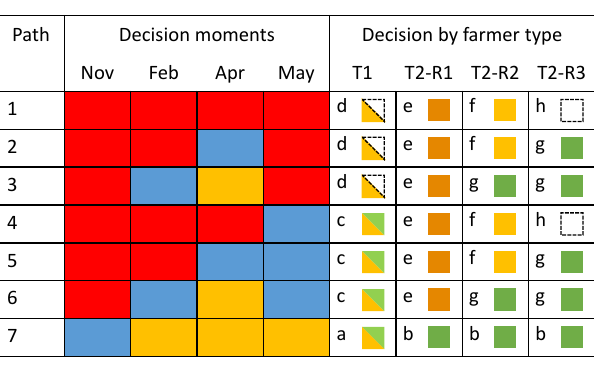
Table 1. Possible paths for farmers. The paths are the result of the water availability (red – poor availability, blue – good availability, yellow – indifferent) at the four decision moments. The letters and coloured boxes in the last four columns correspond to the courses of action in Fig. 3 for each of the farmer types given good or poor availability at the four decision moments. The crops planted when following each of the paths are indicated using the same colours as in Fig.